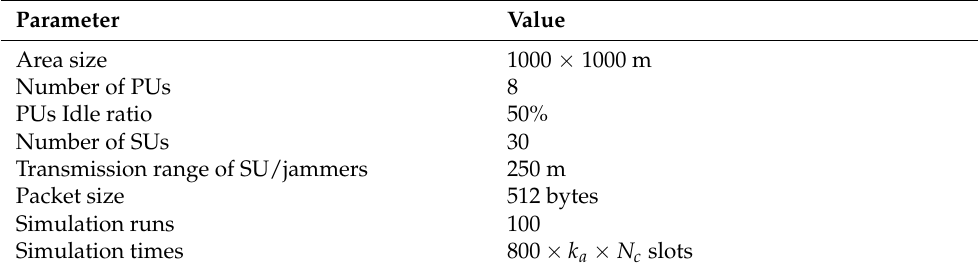
Table 3. Simulation